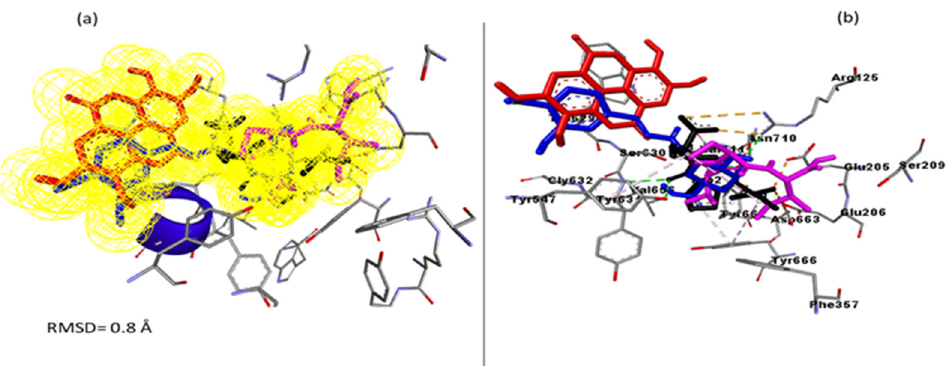
Figure 1. Validation of docking technique and parameters via the superimposition approach against the co-crystal structure of Dipeptidyl peptidase-IV (1WCY). ( a ) The superimposition showed that the docked Diprotin A (purple colour), chlorogenic acid (blue colour), and ellagic acid (red colour) achieved the same orientation with the native inhibitor (black) of 1WCY with a low RMSD value of 0.8 Å. ( b ) showed the investigated compounds and native inhibitors at the binding pocket of DPP-IV displaying active site amino